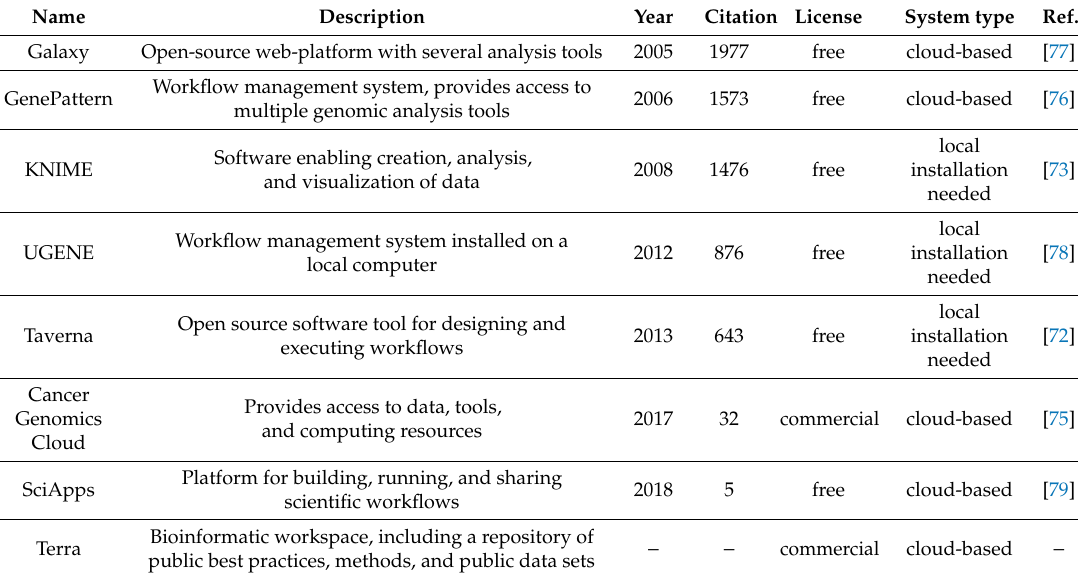
Table 2. Platforms available for bioinformatic